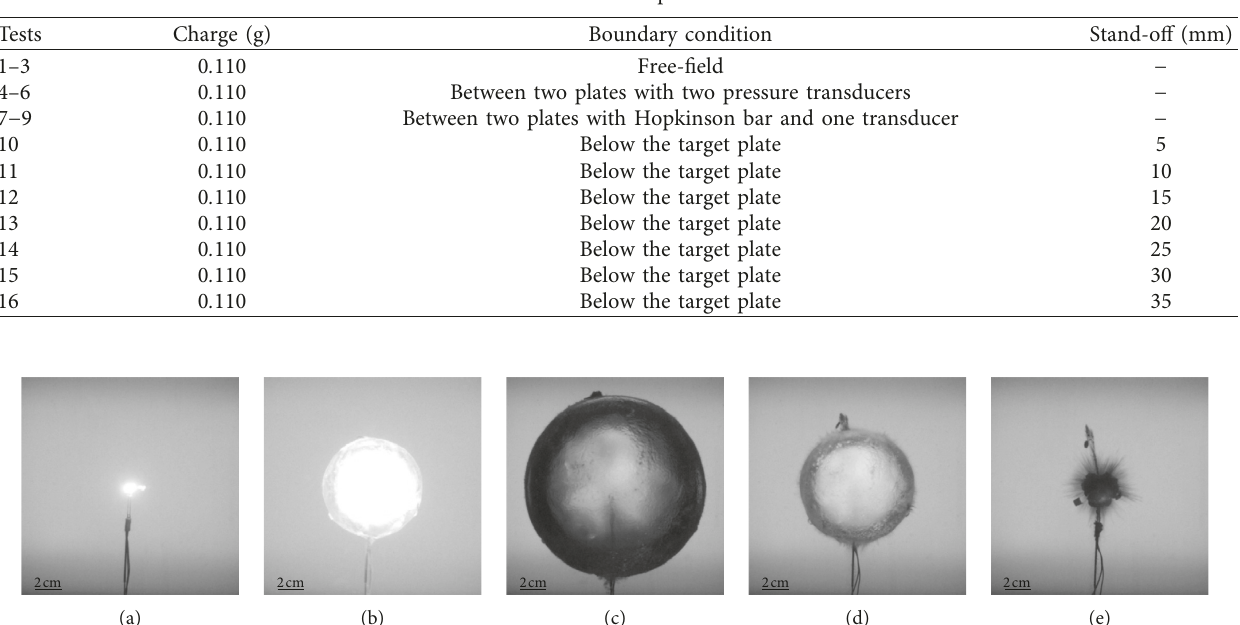
Figure 4: Detailed schematic of the apparatus of the validity system. Table 1: Tests plane.